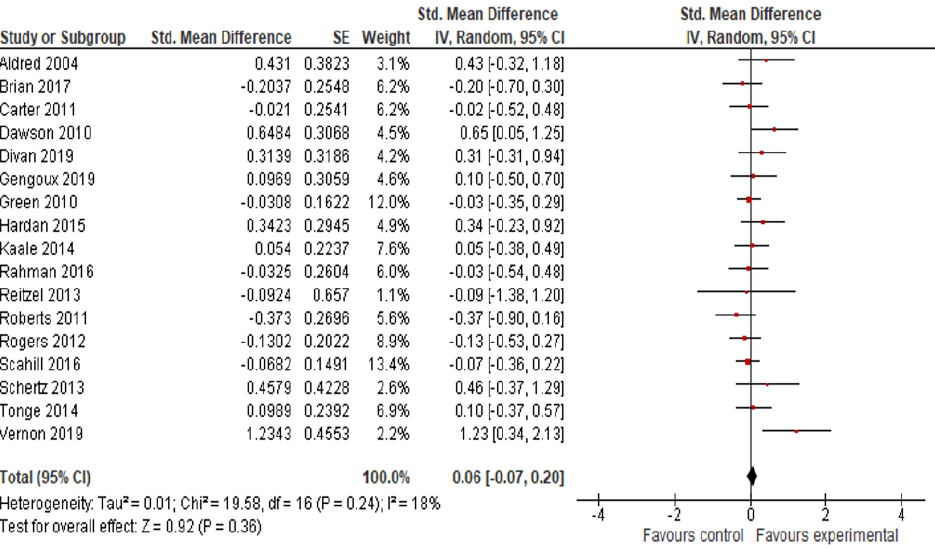
Figure 6. Forest plot for adaptive behavior composite. Overall effect [30,31,35,44,45,49,58].